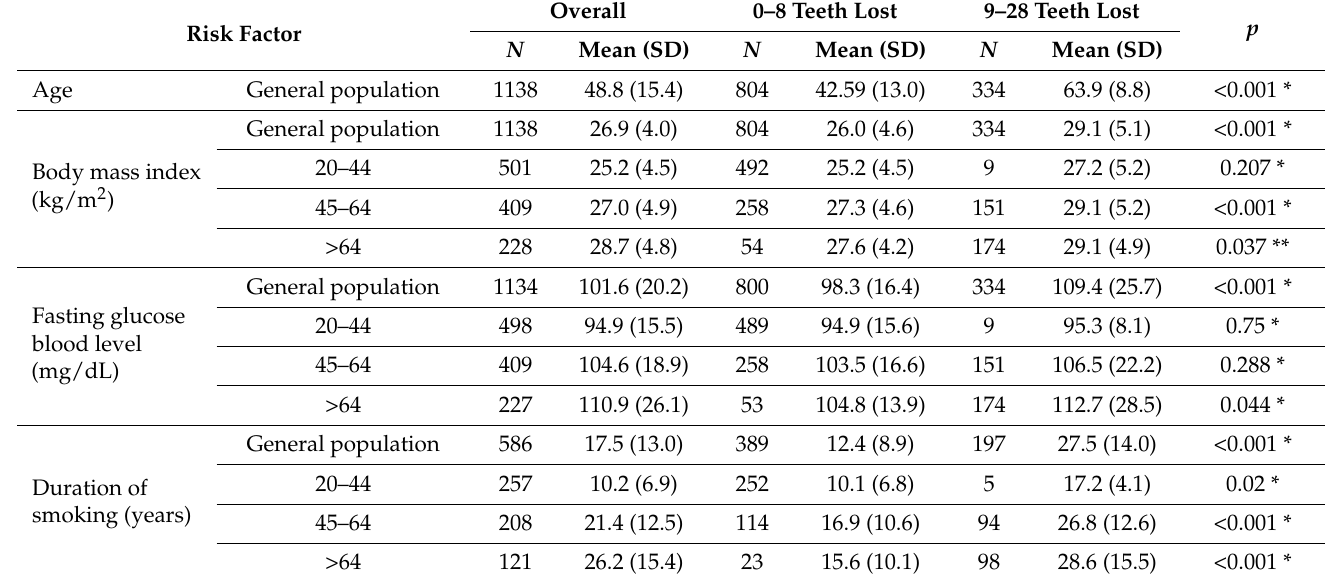
Table 1. The tooth loss (0–8 vs. 9–28) and mean age, BMI, FBG, and duration of smoking. ( p < 0.05,